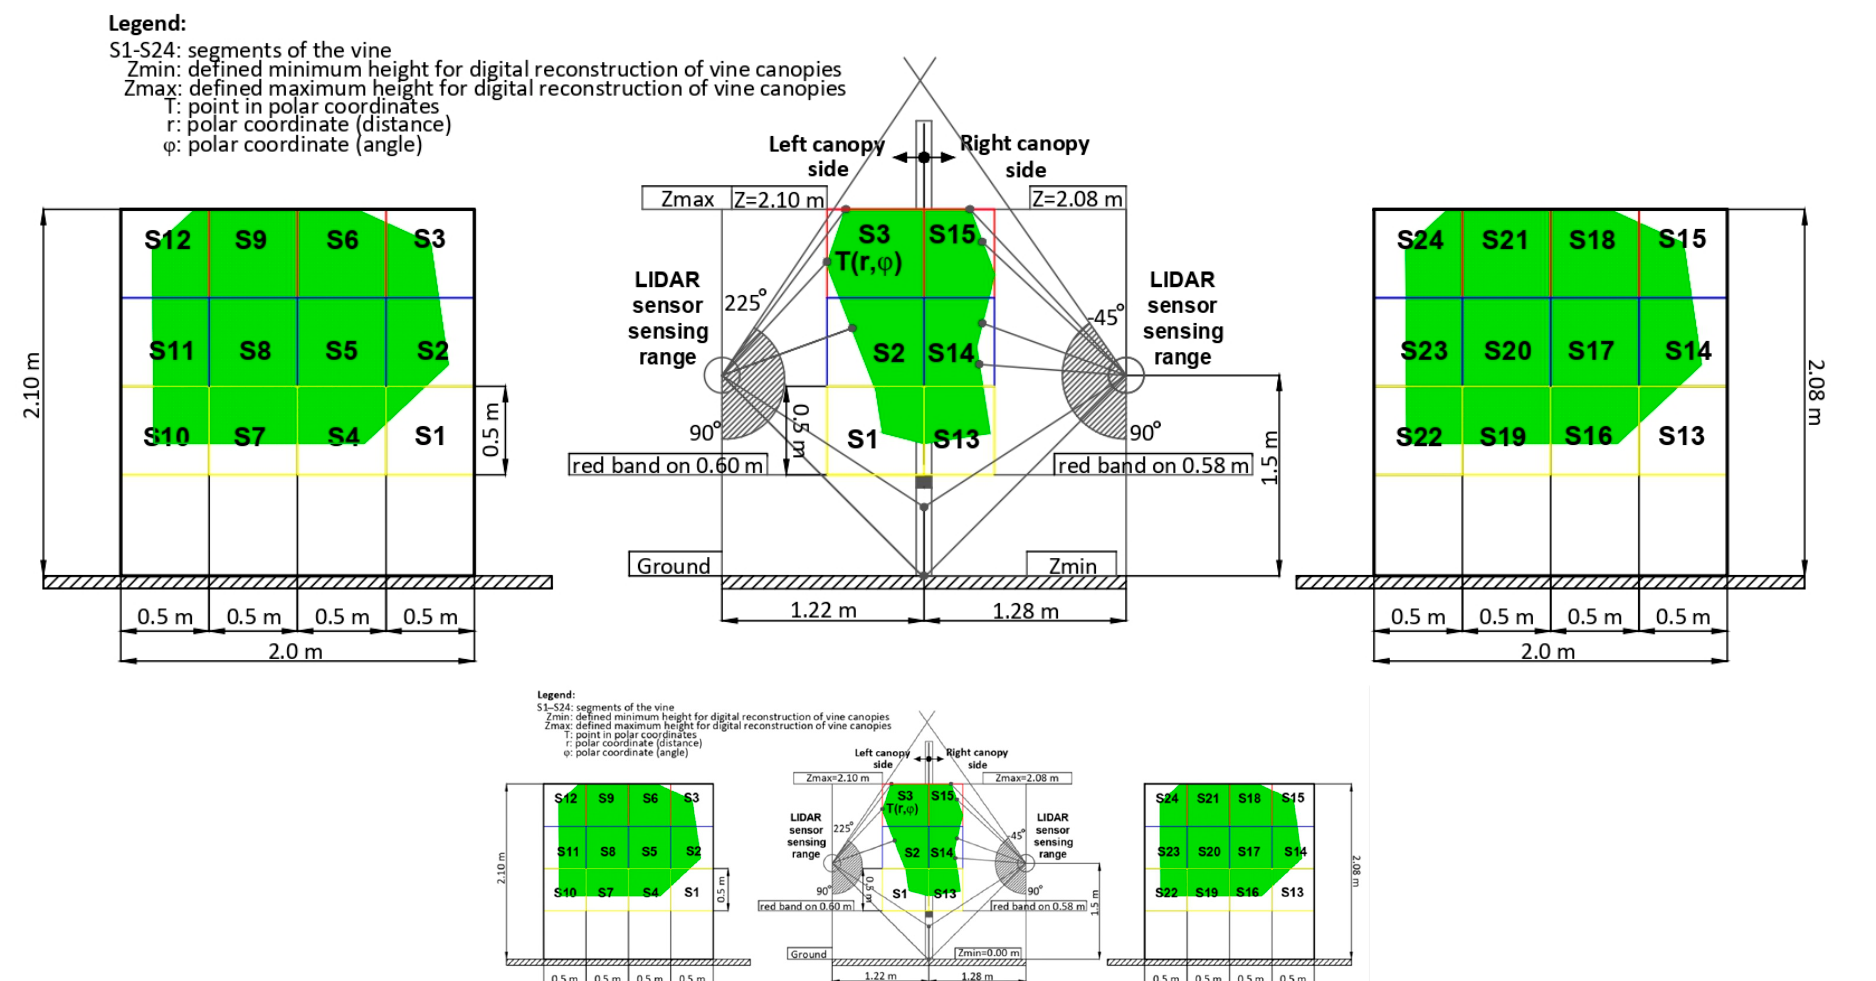
Figure 3. Positioning of the lidar with respect to the vines and numbering of the segments of the vine canopy (two vines on the whole test area). View from the beginning of the row (in the center), with lidar position and detected points on the vine. The left and right images show the canopy view and the annotations that the lidar saw on the left and right sides of the canopy as it moved through the